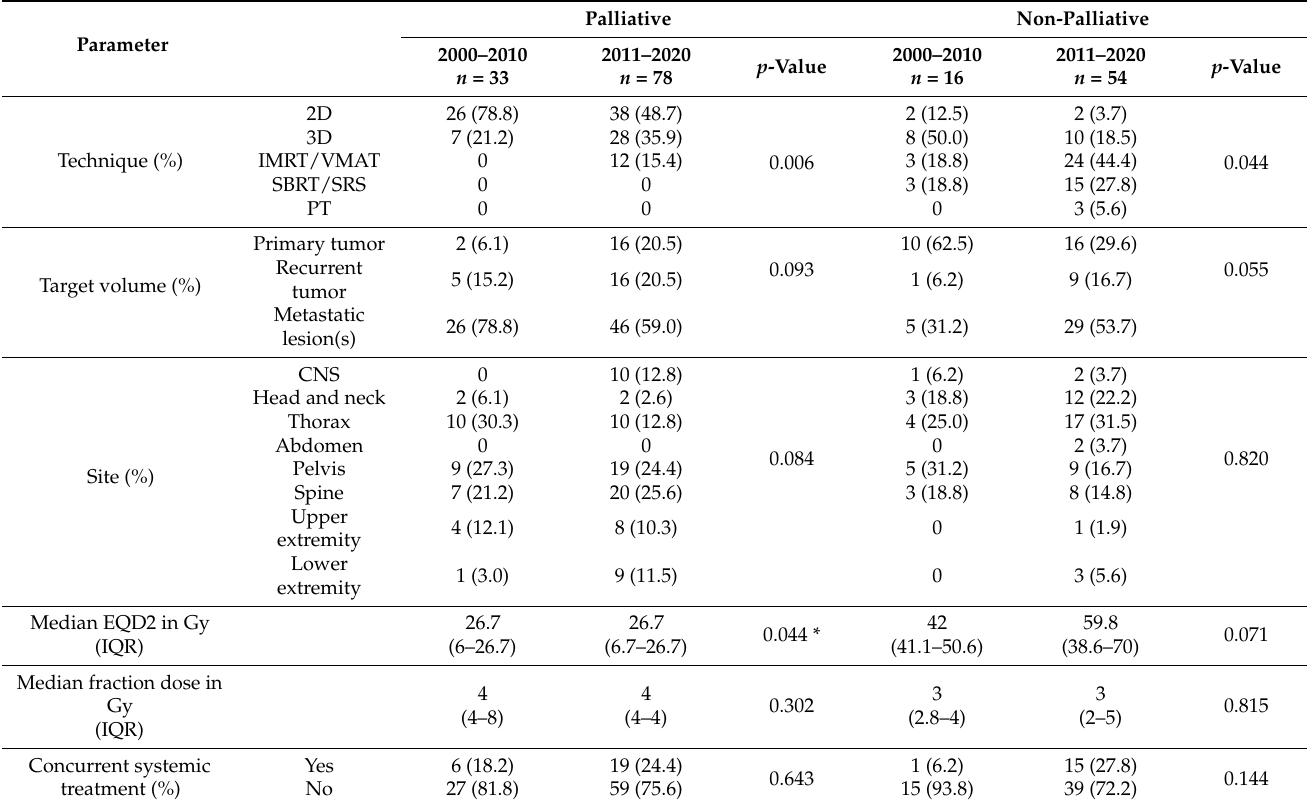
Table 2. Radiotherapy parameters for patients treated with palliative and non-palliative intent.